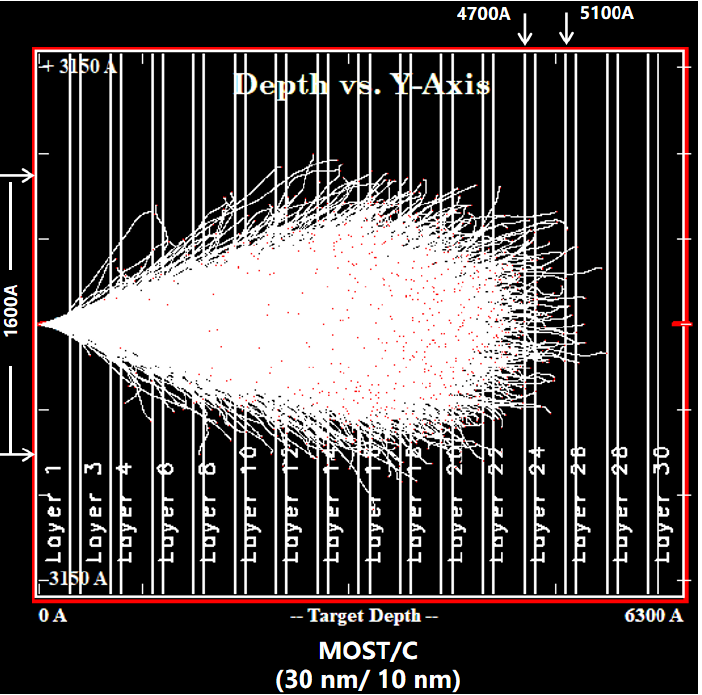
Figure 1. SRIM irradiation simulation results of MOST/C nano-multilayer films (mode: ion distribution and quick calculation of damage).